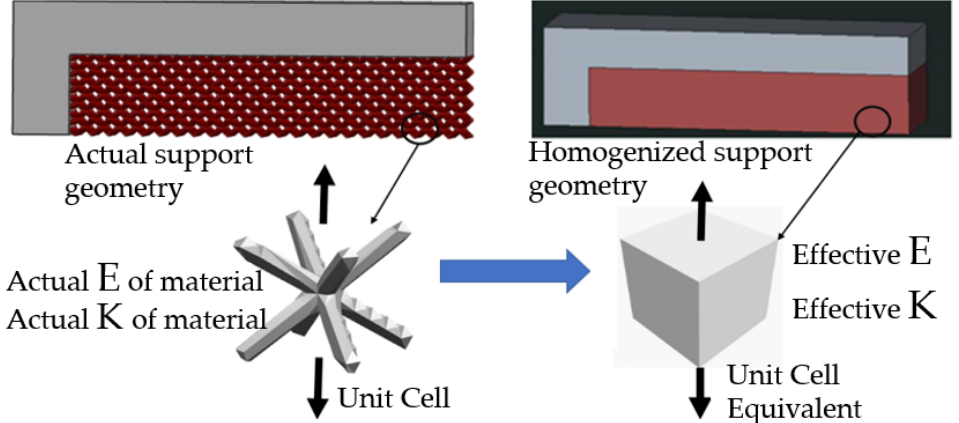
Figure 3. Replacing lattice support geometry with homogenized block support.